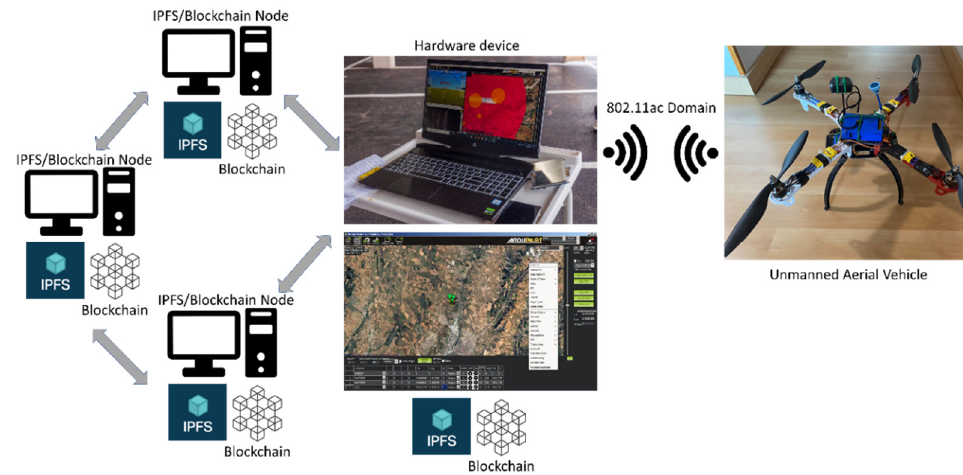
Figure 4. Representation of the proposed system.